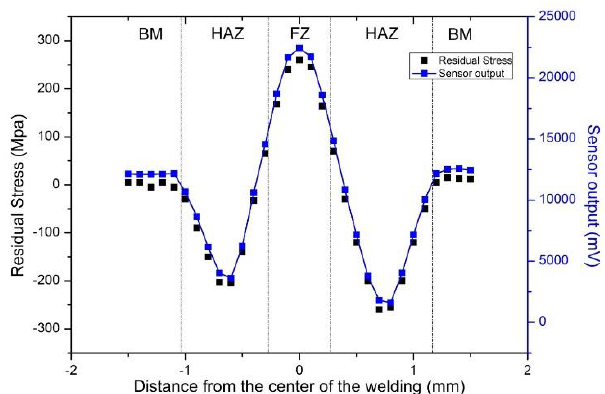
Figure 11. A typical dependence of a welded under-test steel: stress and permeability monitoring across the weld of an AISI 1008 steel. The agreement between stress and permeability distribution is evident.